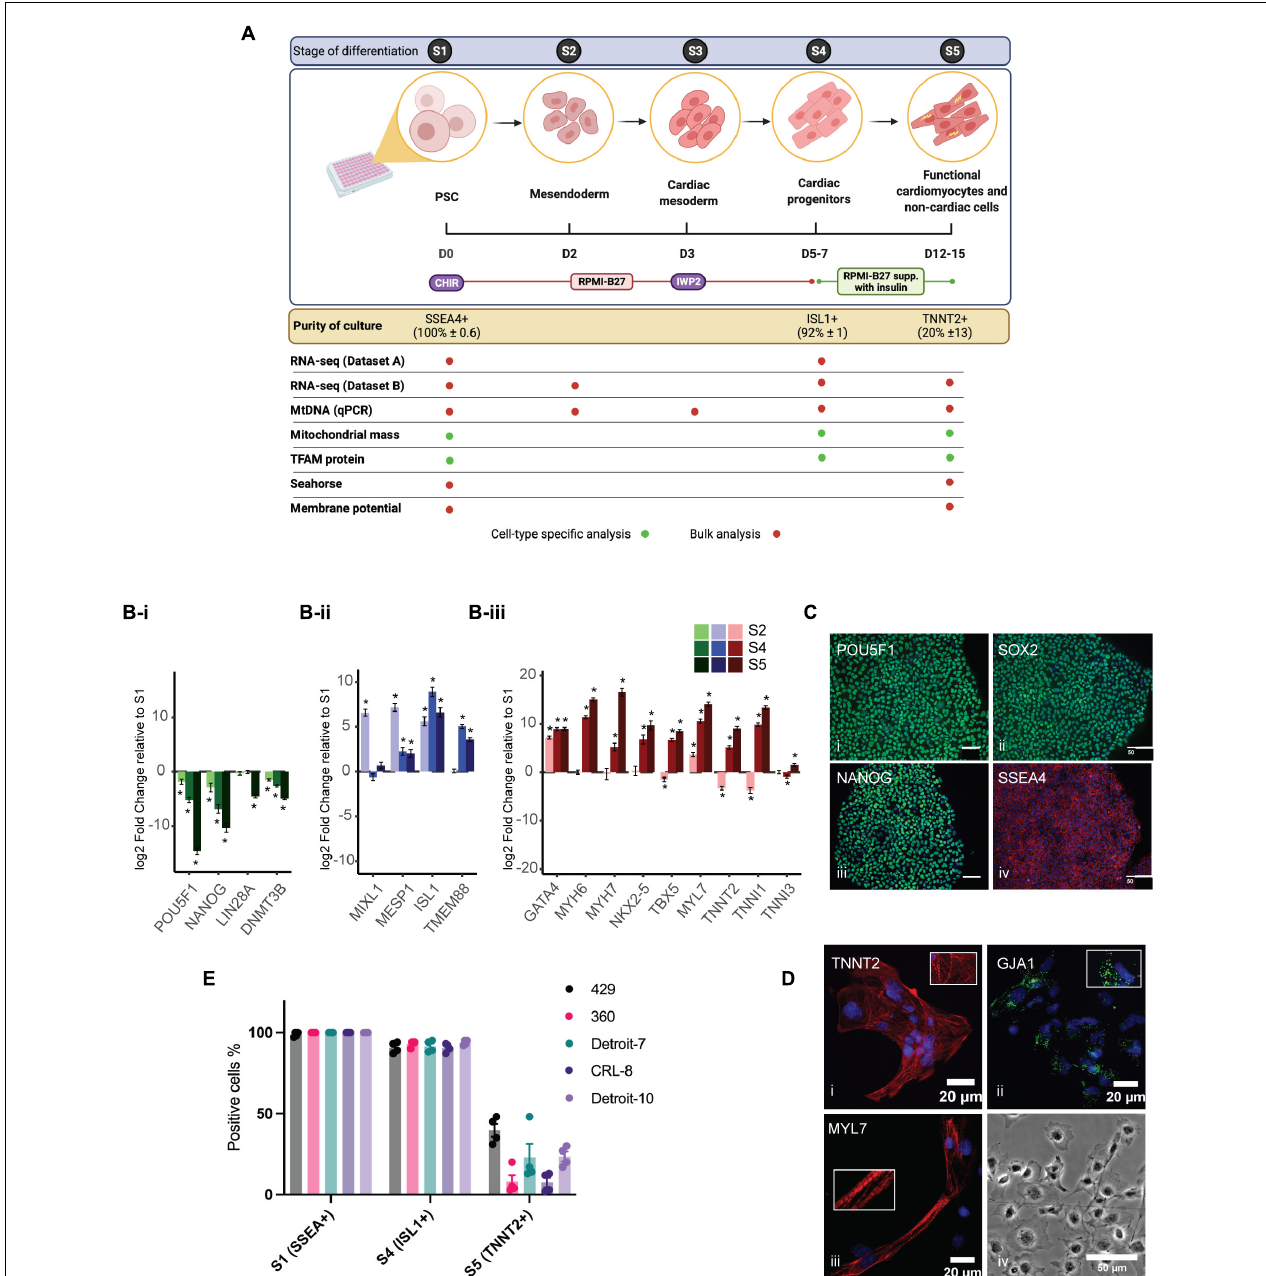
FIGURE 1 | Cardiomyocyte differentiation and characterization. (A) A schematic diagram showing the cardiomyocyte differentiation protocol. The differentiation process was divided into five stages (S1–5), shown in the top panel. hiPSCs were treated with 6 µ M and hESCs with 8 µ M of CHIR99021 (CHIR) on day 1 for 24 h followed by treatment with IWP2, a Wnt signaling inhibitor, for 48 h on day 3 in RPMI supplemented with B27 without insulin. By S4, medium was changed to RPMI supplemented with B27 with insulin. Culture purity was assessed with flow cytometry with stage-specific cell markers (in yellow box). The table shows which experiment was conducted for each stage and whether we assessed a heterogeneous culture (bulk analysis, red dots) or cell-type specific format (green dots). Schematic diagram is created with BioRender.com. (B) Relative expression of known markers for stem cells (B-i) , cardiac progenitor (B-ii) , and cardiomyocytes (B-iii) were assessed using RNA-seq data from H1 (Dataset B). (C) hPSCs examined for expression of stem cell-specific markers using a panel of antibodies: POU Class 5 Homeobox 1 (POU5F1, also known as OCT4), SRY-box 2 (SOX2), NANOG Homeobox (NANOG), and stage-specific embryonic antigen-4 (SSEA4). Scale bars demonstrate 50 µ m. (D) hPSC-derived cardiomyocytes were stained for cardiomyocyte-specific markers: cardiac muscle troponin T-type 2 (TNNT2), Gap Junction Protein Alpha 1 (GJA1), and Atrial Light Chain-2 (MYL7). Pictures show co-immunostaining of the cell-specific markers (labeled on the image) and nucleus (blue). (D-iv) A bright field image of cardiac cells at S5 (transferred from a 96-well plate to cover glass at S4). (E) The bar charts represent the purity of cultures at three critical stages of mesoderm differentiation and the variation among the lines. Each dot represents a single differentiation; error bars are the SD of the mean. hiPSCs, human induced pluripotent stem cells; hESCs, human embryonic stem cells; RPMI, Roswell Park Memorial Institute; hPSCs, human pluripotent stem cells.